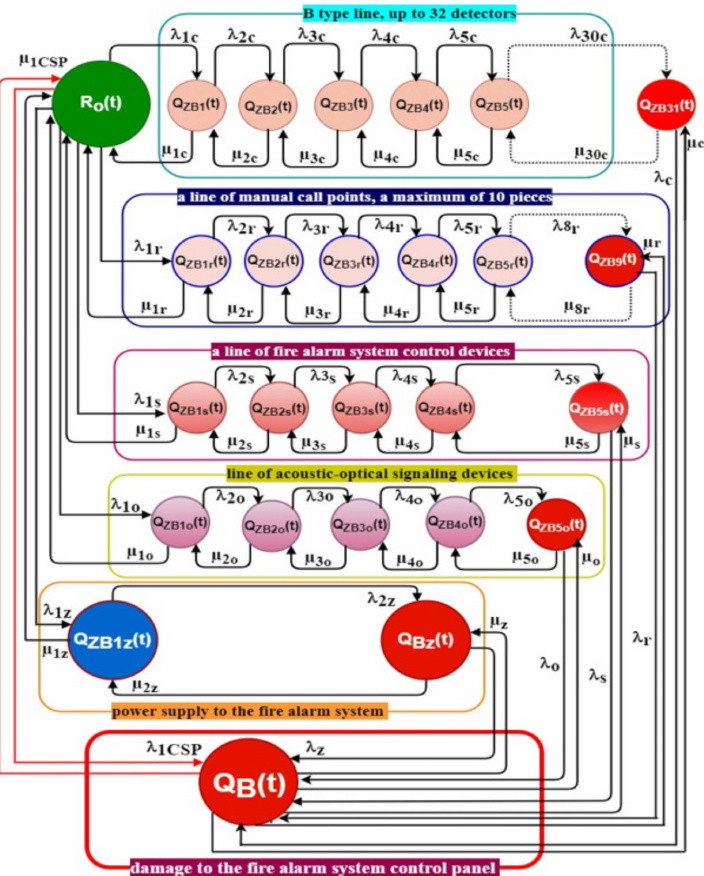
Figure 14. Operating states occurring in the course of operating a focused FAS with an addressable fire alarm control unit with detection and monitoring control on B-type radial lines, B-type audio and optical signaling device lines and MCPs, taking into account power supply unreliability—industrial mains and backup power